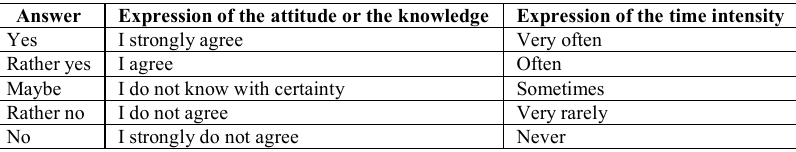
Table 1. Answers of the five-step scaled